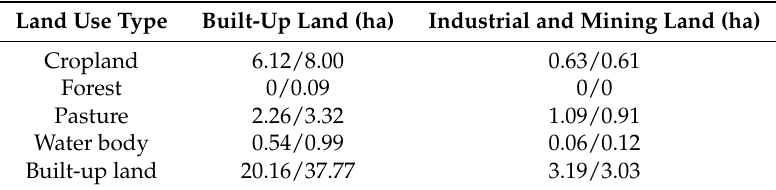
Table 4. Railway/road buffer transfer matrix of land